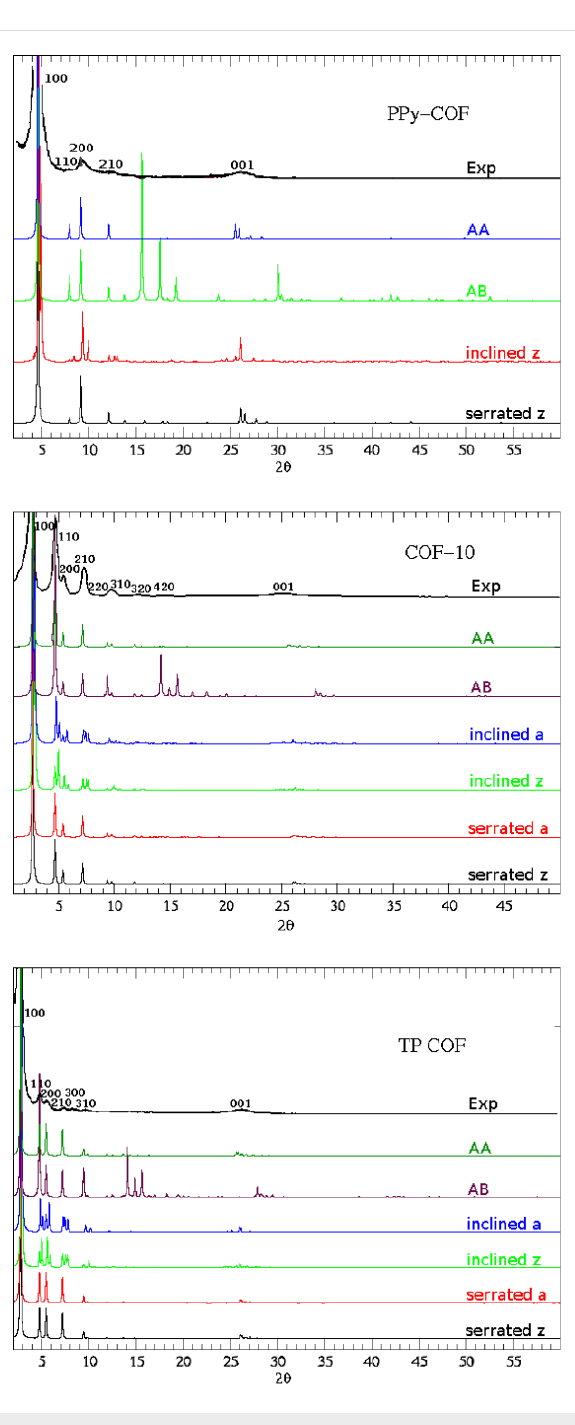
where E nl tot is the total energy of n s number of layers stacked in a COF. Finally, the COF formation energy can be given as a sum of E c,b and E s,b . The calculated energies are given in Table 2 (and Table S4 in Supporting Information File 1) for all the studied stacking